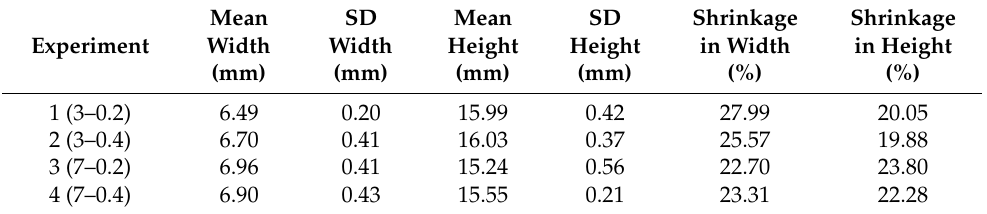
Table 3. Mean and standard deviation (SD) of width, height, and shrinkage of the printed samples. Experiment